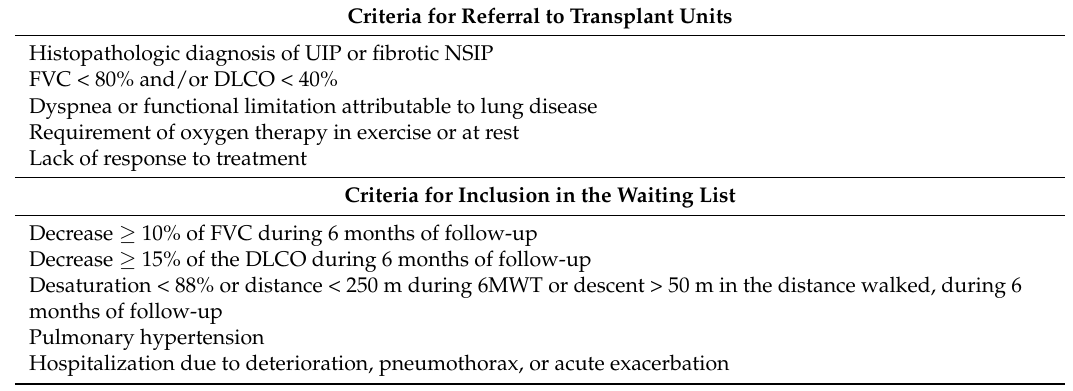
Table 2. Criteria for referral and inclusion in the waiting